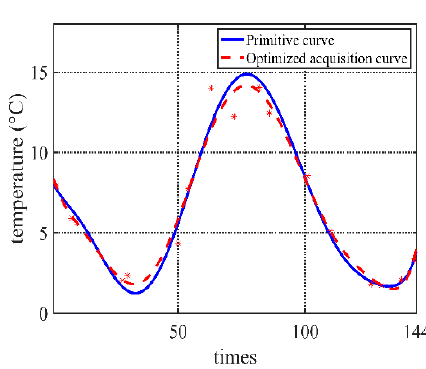
Figure 8. Comparison when FIT max = 0.75.